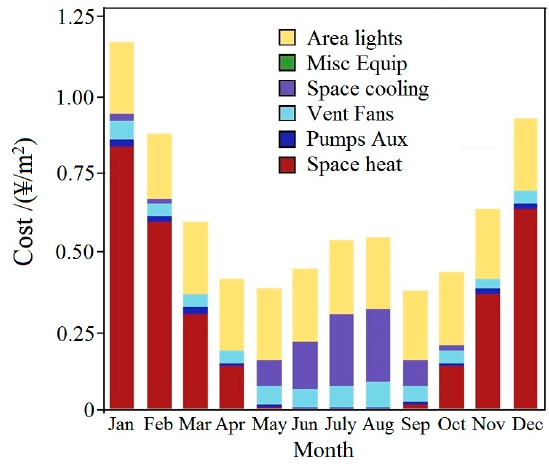
Figure 14. Total energy cost monthly through a year.